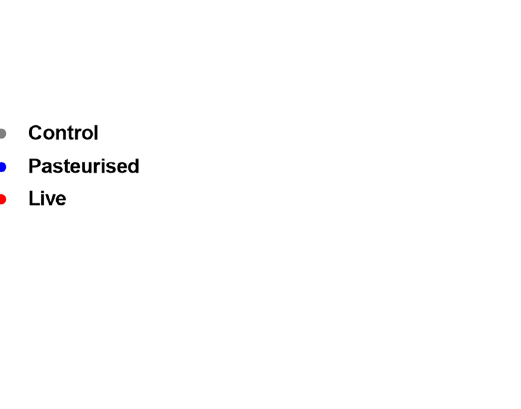
Figure 5. Serum biochemical markers after oral administration of P. copri for 29 days. ALAT, alanine aminotransferase; ASAT, aspartate aminotransferase; ALP, alkaline phosphatase; ALB, Albumin; CRP, C-reactive protein. Samples which showed signs of haemolysis were not included in the analysis. Control and pasteurized P. copri n = 7, live P. copri n = 9.